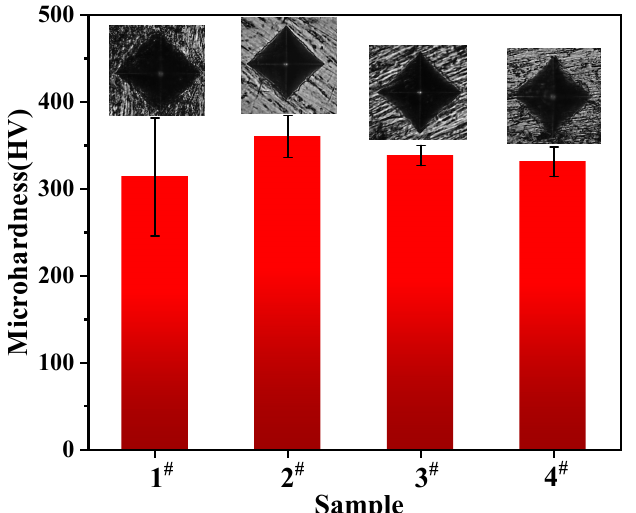
Figure 5. The microhardness of Ti-40Nb-10Ag for different sintering temperature (1 # ,2 # ,3 # ) and Ti-40Nb alloy (control group-4 # ).